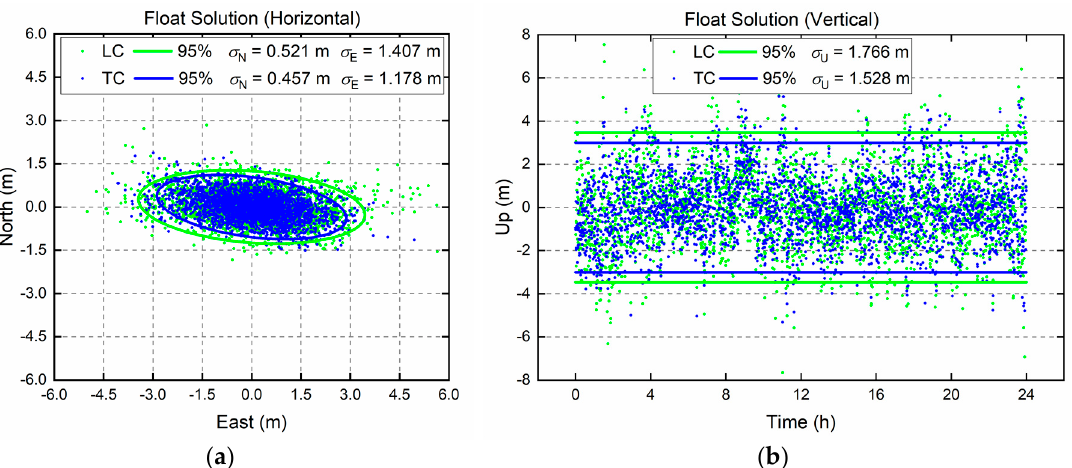
Figure 5. Float solutions with respect to the horizontal biases ( a ) and the vertical biases ( b ). Green dots and lines are for the loose combination (LC) and blue are for the tight combination (TC). The ellipsoids in ( a ) and lines in ( b ) show the bias within the 95% confidence level. The position root-mean-square errors (RMSEs) in the TC model and LC model using all six